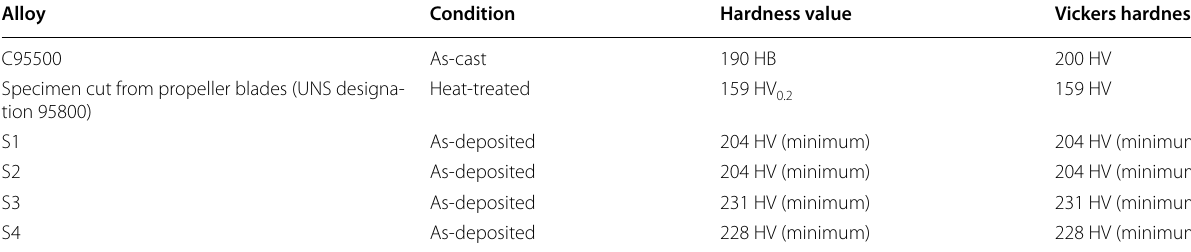
Table 4 Hardness of UNS ASTM NAB and as-deposited NAB